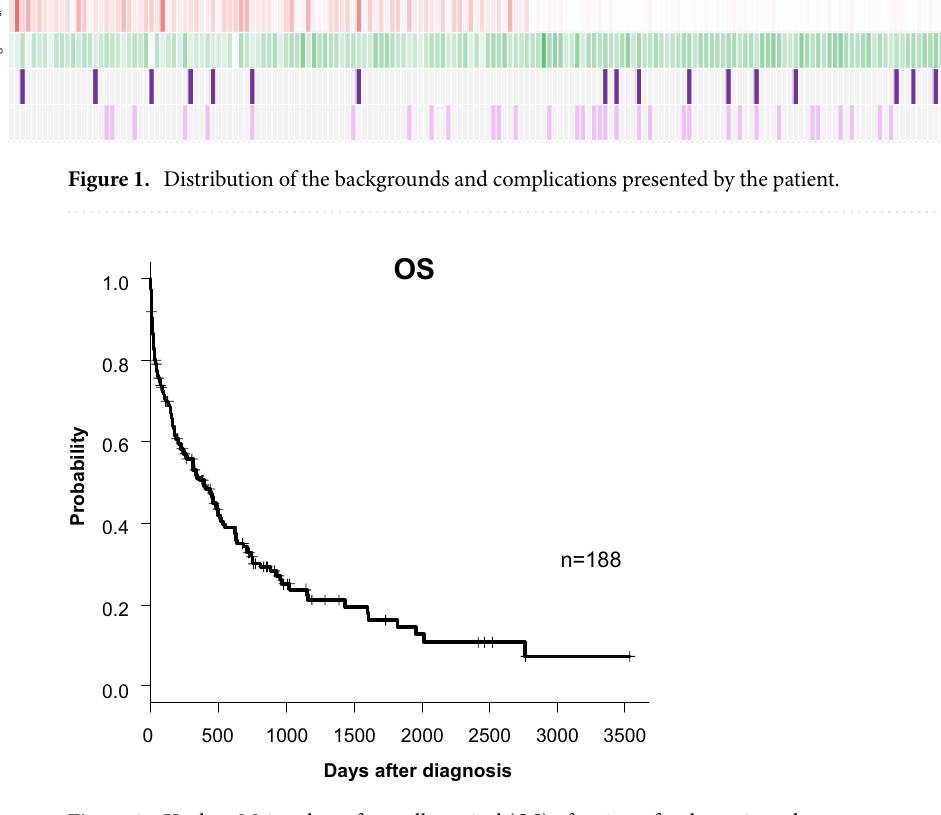
Figure 2. Kaplan–Meier plots of overall survival (OS) of patients for the entire